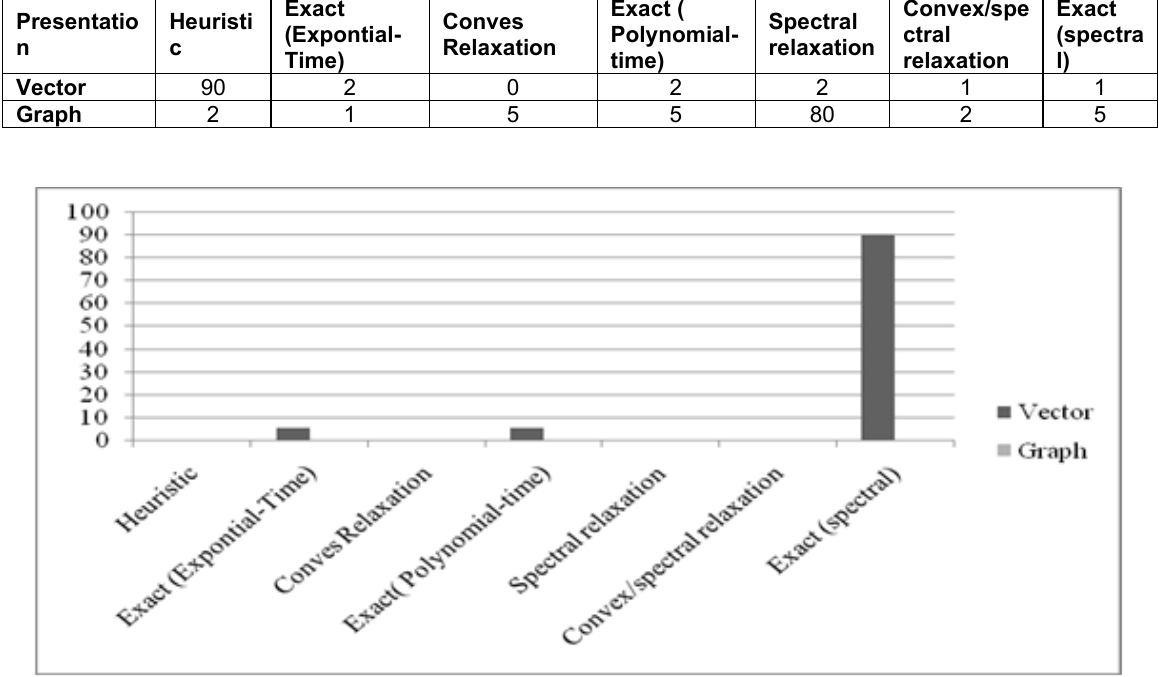
Figure 4. C hart representing approaches and presentation of